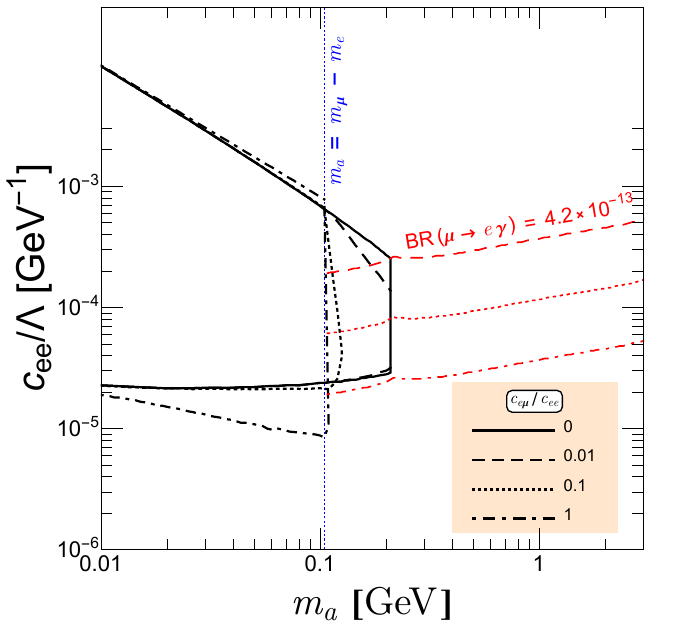
Figure 7 . The same plots as figure 6 for the pseudoscalar interaction. The CLFV coupling is taken to c eµ /c ee = 0 (solid), 0 . 01 (dashed), 0 . 1 (dotted), and 1